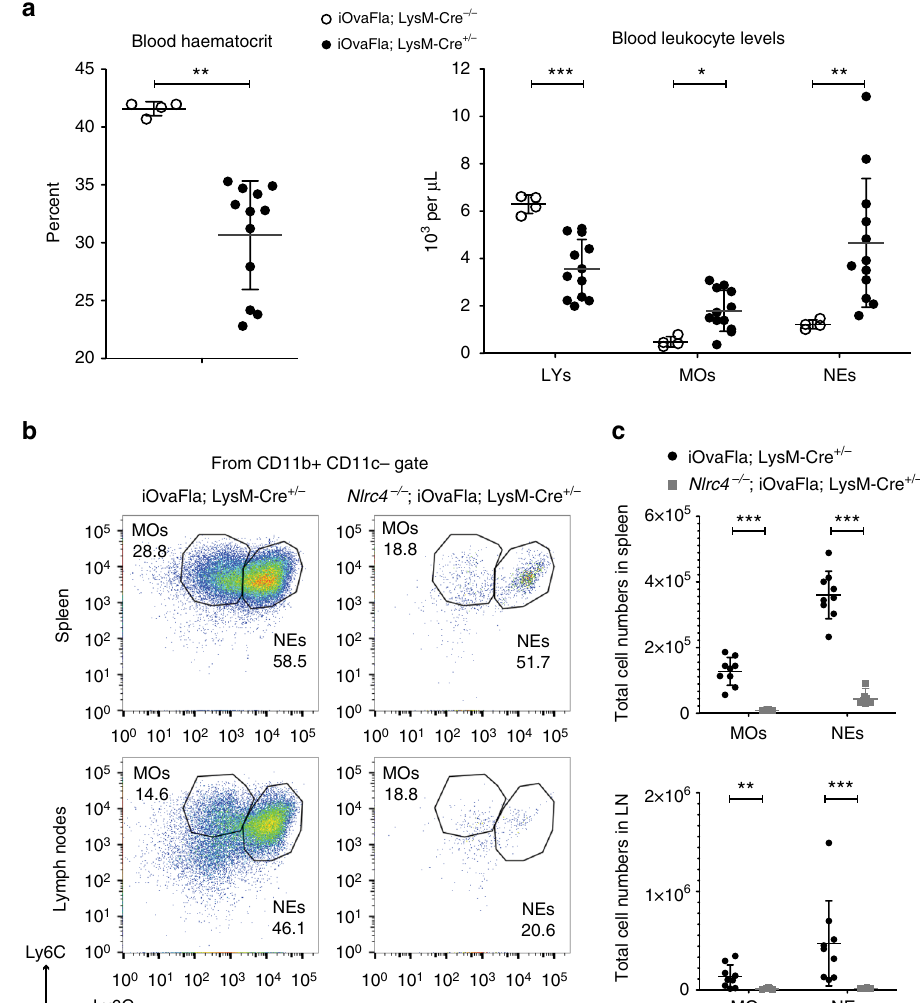
Fig. 3 In fl ammasome-driven disease leads to myeloid cell hyperplasia. a Haematocrit concentration and cell numbers from a complete blood count (CBC) performed on the blood of 10-week-old iOvaFla; LysM-Cre +/ − and iOvaFla; LysM-Cre – / − mice. b Flow cytometry and c quanti fi cation of total monocytes (MO; CD11b + Ly6C Hi Ly6G Lo ) and neutrophils (NE; CD11b + Ly6C Lo Ly6G Hi ) from mice aged 10 – 16 weeks old. Flow cytometry plots are representative of three separate experiments. Dot plot percentages are from CD11b + gate, and cell numbers are calculated from percentage of live cells (total cells). Data in a are representative of two independent experiments; Data in b , c are representative of three independent experiments. Error bars are s.d. Results were analysed with either a Mann – Whitney test or two-way ANOVA and Bonferroni post-tests; * p < 0.05, ** p < 0.01, *** p < 0.001 NATURE COMMUNICATIONS | 8: 2209 | DOI: 10.1038/s41467-017-02266-w |